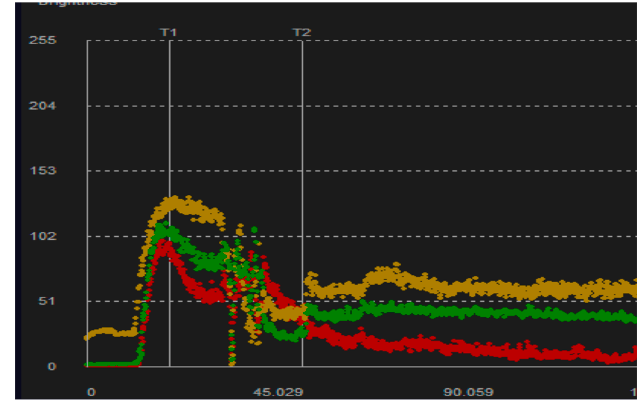
Figure 2. TIC after contrast injection showing the contrast-enhancement and washout at the three ROIs. Arterial flow is determined in the interlobar arteries and in the renal cortex using